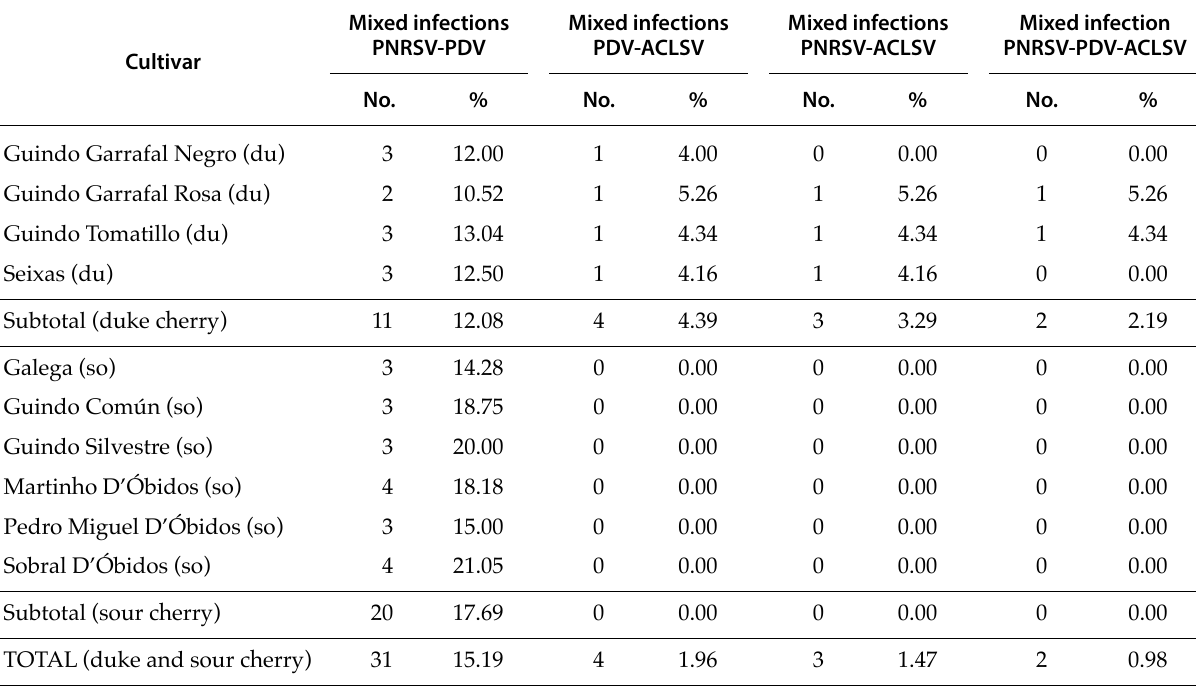
Table 2. PDV, PNRSV and ACLSV mixed infections in sour (so) and duke (du) cherry cultivars from the Iberian Peninsula. ELISA